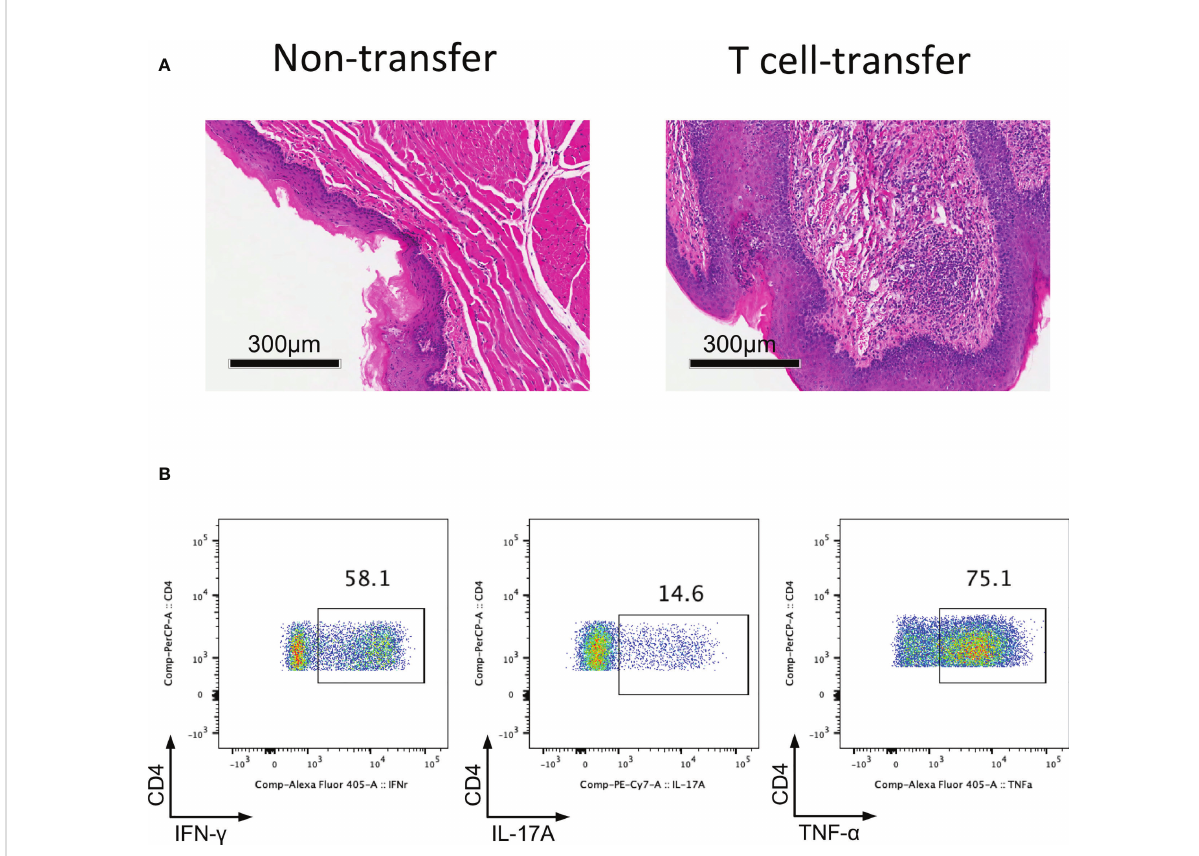
FIGURE 3 Adoptively transfer CD4 + CD25 - CD45Rb high T cells into Rag1 -/- mice induces oral mucosal in fl ammation. CD4 + CD25 - CD45RB high T cells sorted by fl ow cytometry from spleens and peripheral lymph nodes (PLNs) of CD45.1 mice were injected into Rag1 -/- mice, and oral mucosa of Rag1 -/- mice was harvested 8-10 weeks post T cell transfer (n=3). (A) Representative histology images of oral mucosa sections. (B) Representative fl ow cytometry plots showing frequencies of Th1 cells, Th17 cells and CD4 + TNF- a + cells in DLNs of the oral cavity in T cell transfer mice. Data are representative of two independent